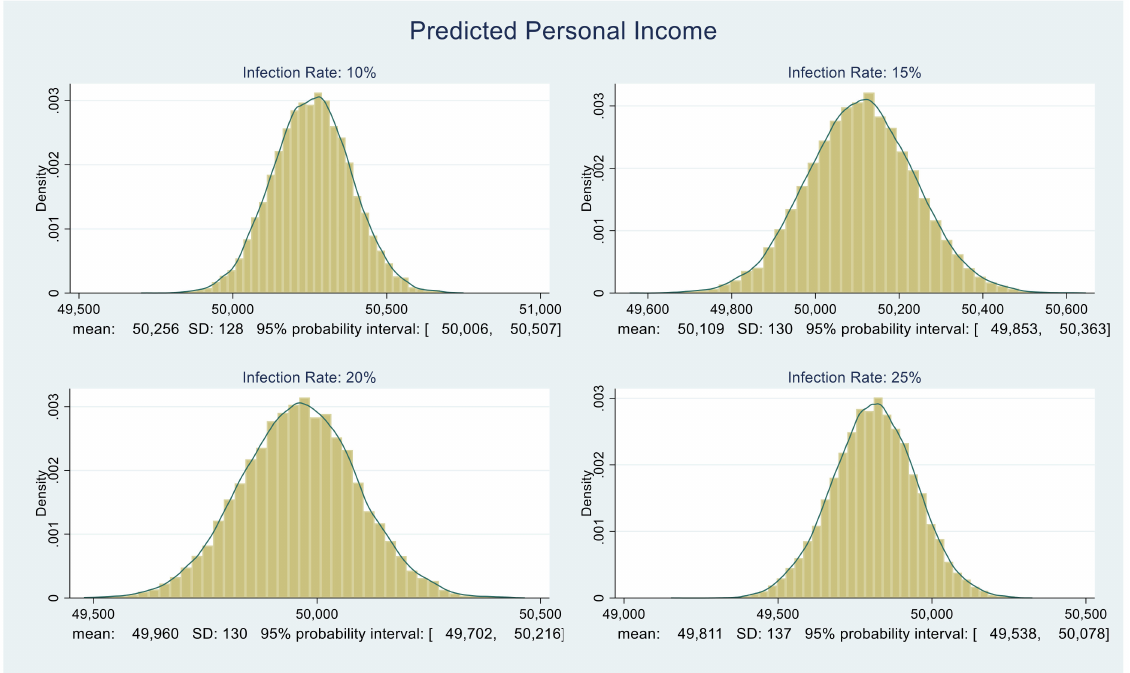
Figure 3. Predictive distributions of Florida unadjusted personal income in dollars.